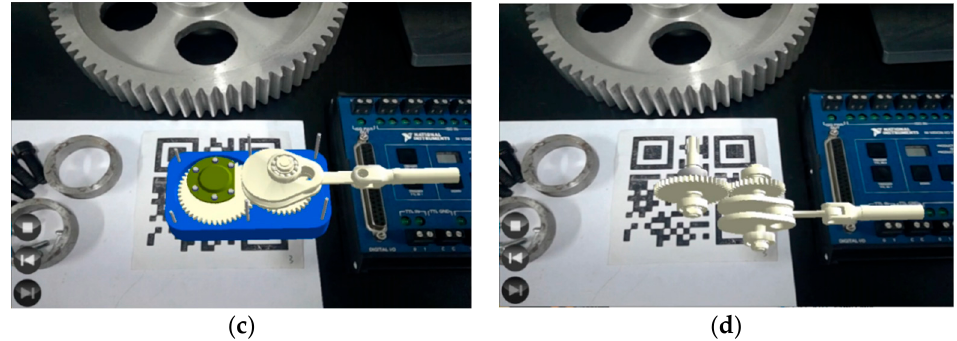
Figure 12. Assembly disassembly animation demonstration: ( a ) initial page; ( b ) top cover is hidden; ( c ) middle shell is hidden; ( d ) operation demonstration.